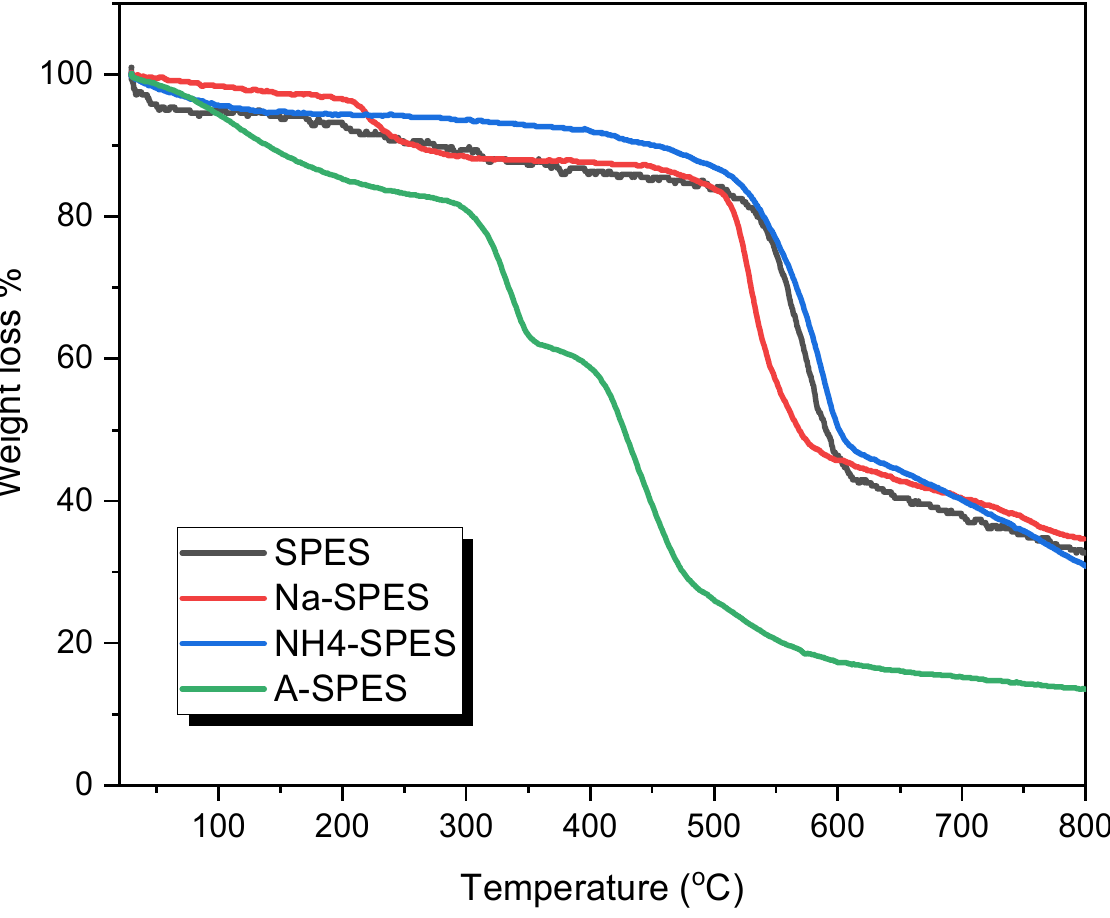
Figure 5. TGA thermograms of the modified PES materials.